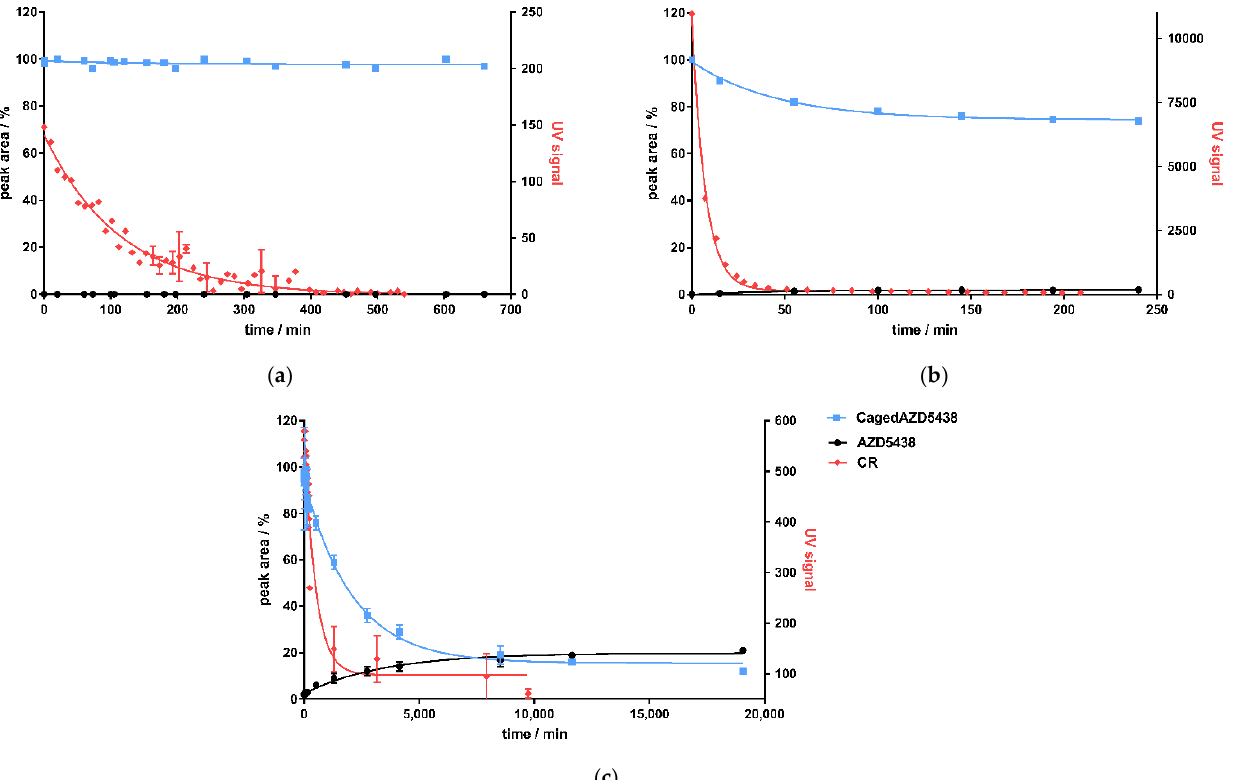
Figure 5. Correlation of CR detected by the KK method as UV signal (red dots) and uncaging of cagedAZD5438 (blue line) by HPLC analysis to yield uncaged AZD5438 (black) for 3 isotopes: ( a ) 18 Fluor, ( b ) 68 Gallium, and ( c ) 90 Yttrium. All curves are fitted with one ‐ phase decay.